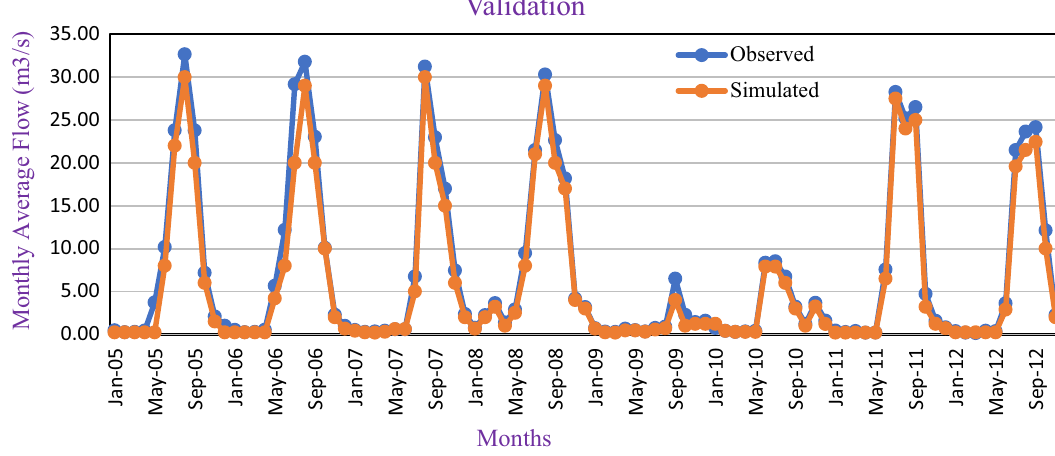
Fig. 13 Shows the monthly average flow of observed and simulated